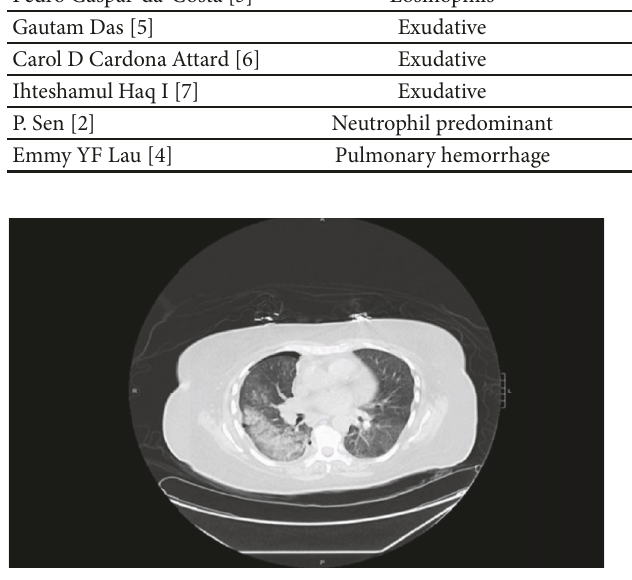
Figure 2: Presence of ground glass opacity suggesting pneumonitis after removal of pleural